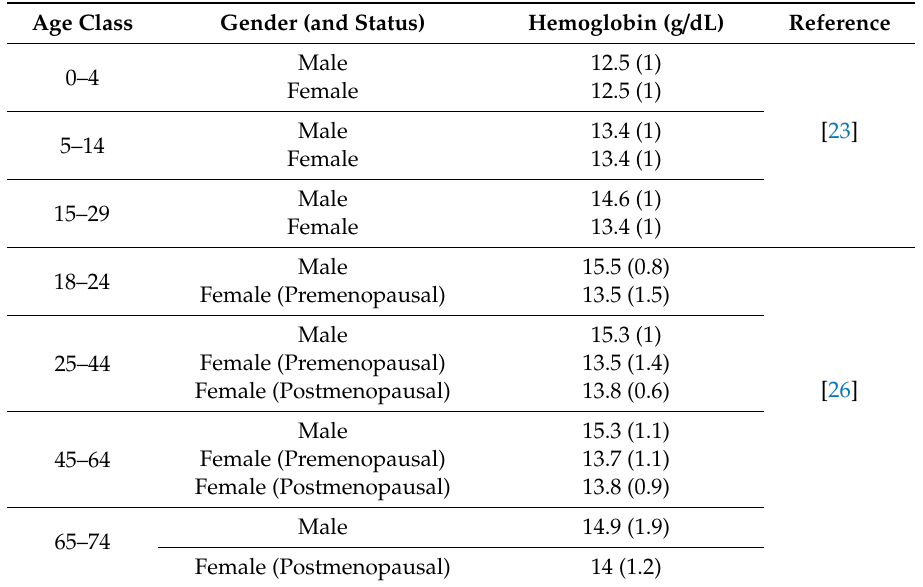
Table A1. Hemoglobin levels values of French population expressed in mean and (standard deviation) extracted from Stoltzfus et al. (2004) and Sant é Publique France